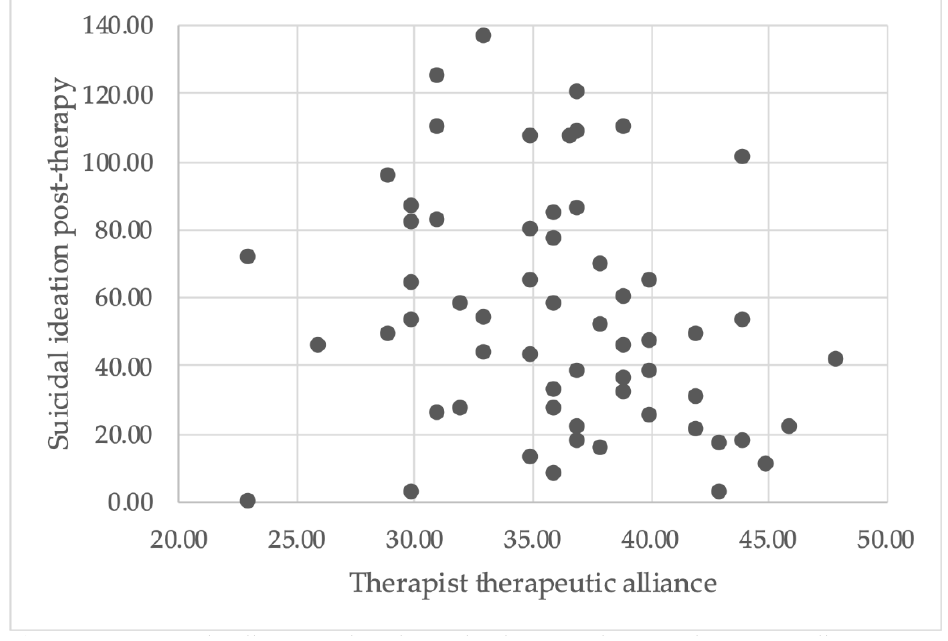
Figure 2. A scatterplot illustrates the relationship between therapist therapeutic alliance scores and severity of suicidal ideation post-therapy.